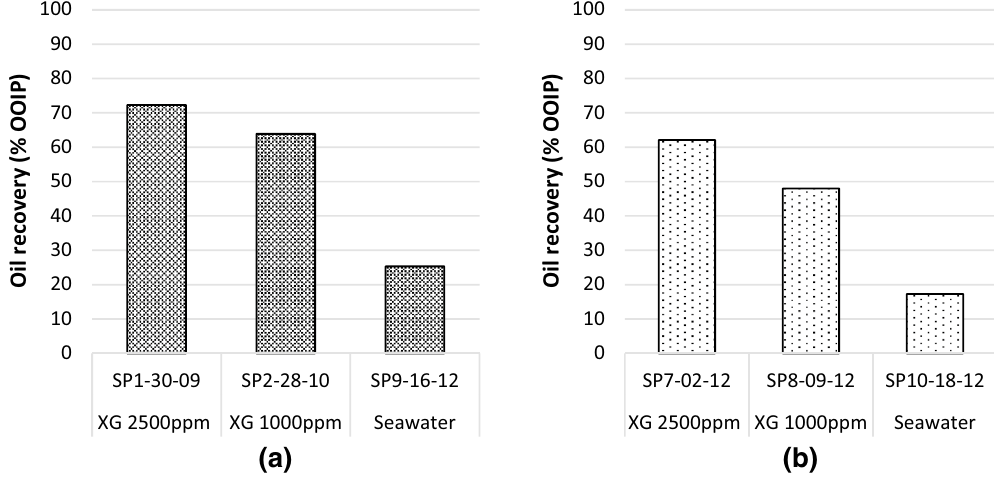
Fig. 9 Oil recoveries from various sandpacks a motor oil and b heavy oil blend as the displaced